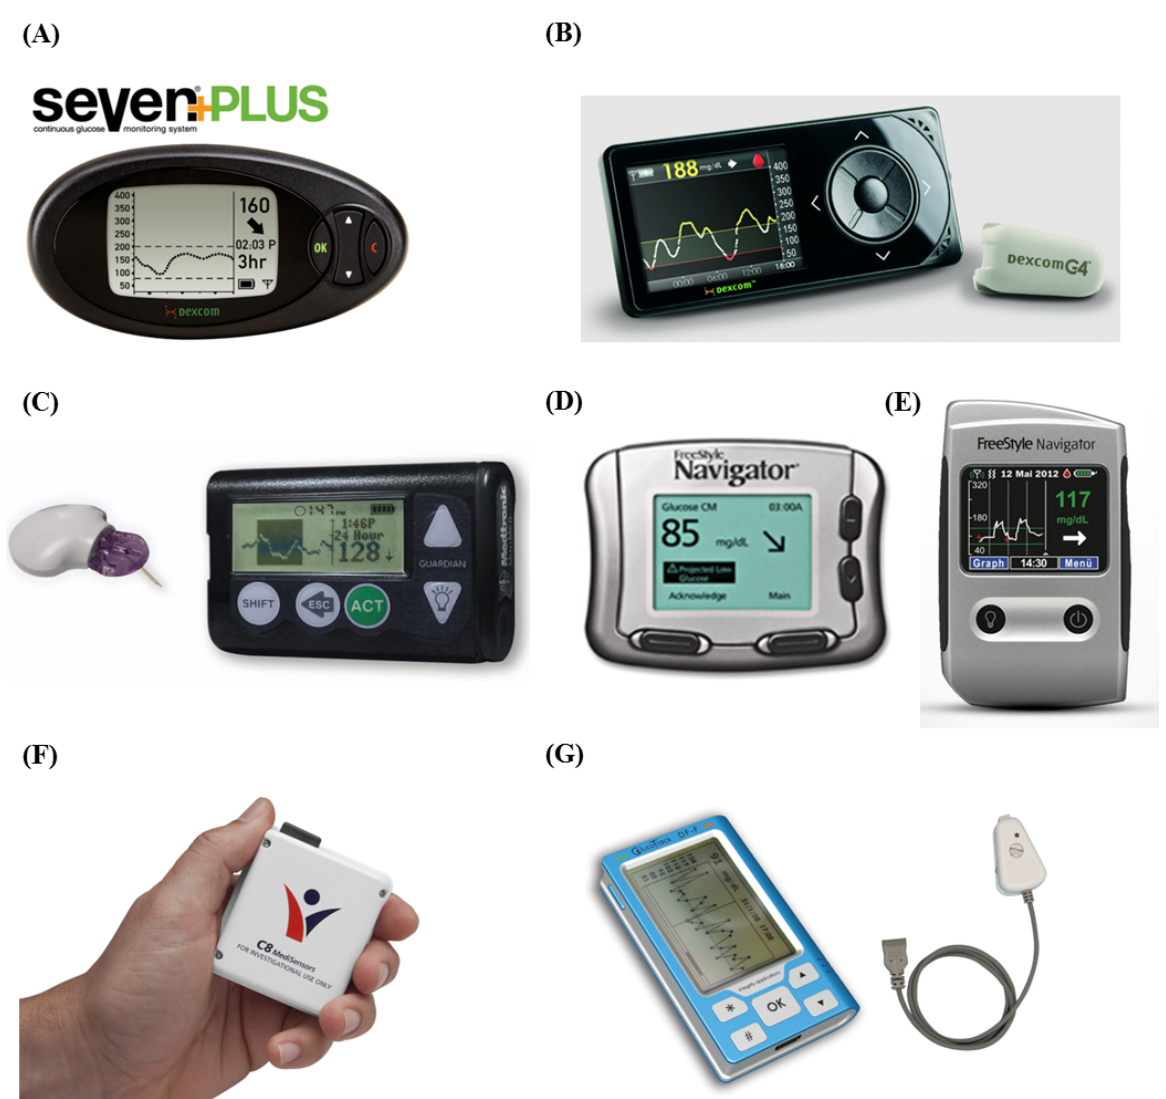
Figure 2. Continuous glucose monitoring systems (CGMS). ( A ) Dexcom SEVEN ® Plus, ( B ) Dexcom G4 TM , ( C ) Guardian REAL-time, ( D ) FreeStyle Navigator ® , ( E ) FreeStyle Navigator II, ( F ) HG1-c and ( G ) GlucoTrack TM